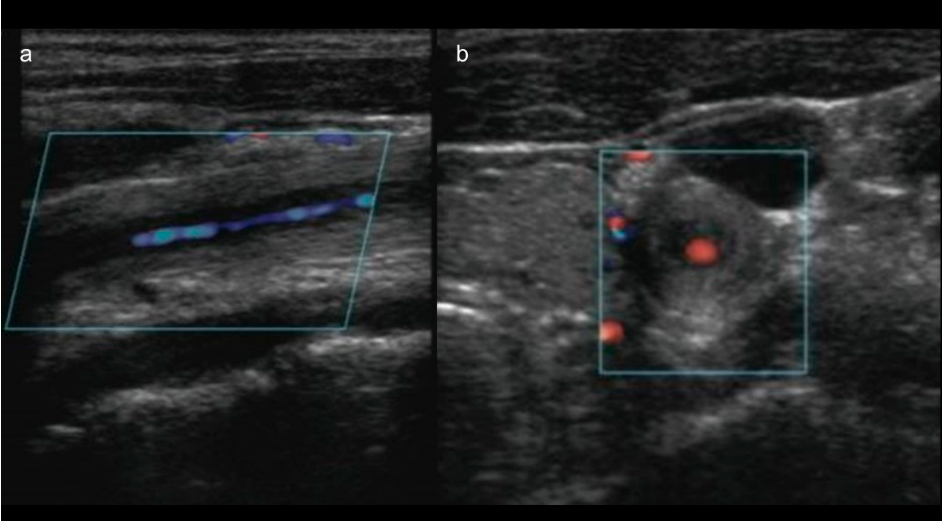
Figure 3. ( a ) Long-axis and ( b ) short-axis view of color Doppler ultrasonography of a 14-year-old female patient with TA showing the “macaroni sign”: circumferential wall thickening of the CCA.